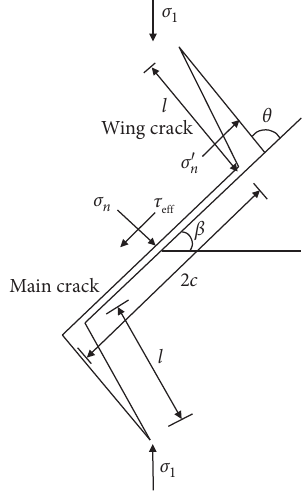
Figure 2: Sliding crack